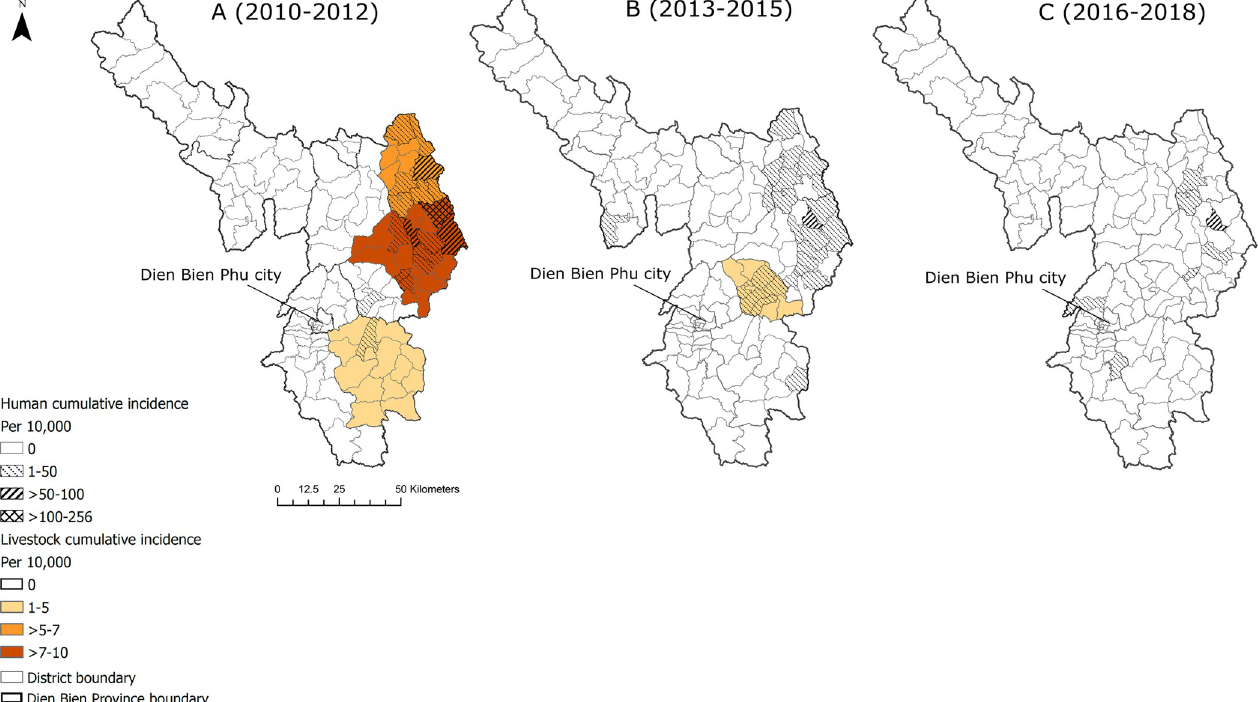
Fig 6. Choropleth maps identifying spatial overlap of human and livestock anthrax in 3-year intervals by crude cumulative incidence (per 10,000) for Dien Bien province, Vietnam. Maps produced in ArcGIS Pro using political boundary shapefiles from https://geodata.ucdavis.edu/gadm/gadm4.1/shp/